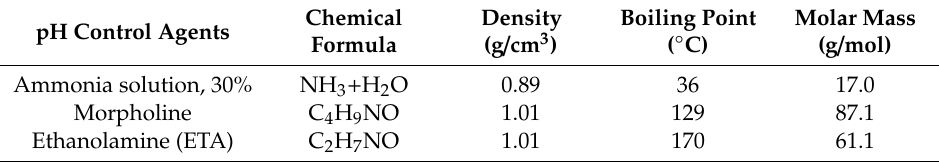
Table 1. Basic properties of three pH agents used in this